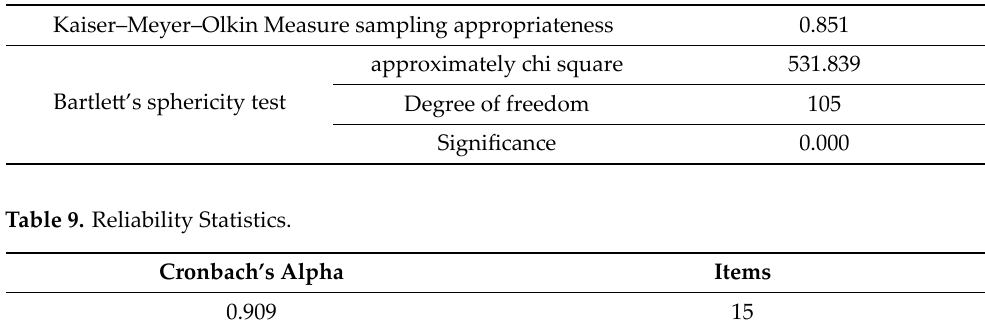
Table 8. KMO and Bartlett Verification.